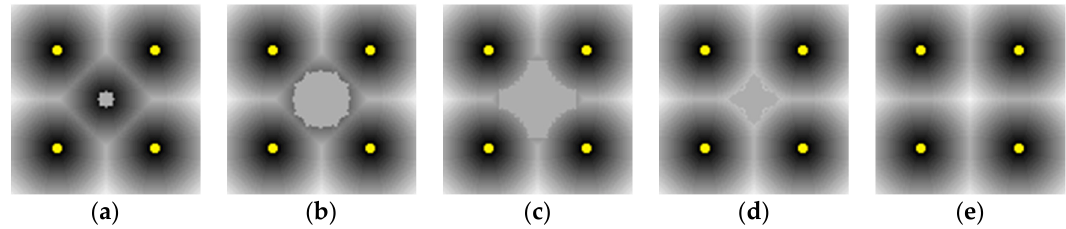
Figure 5. Raise wavefront propagation. ( a ) Remove the center obstacle; ( b ) Launch a raise wavefront; ( c ) Propagate the resetting to the invalid edges; ( d ) Continue the lower wavefront from other sides; ( e )The invalid region is again submerged.